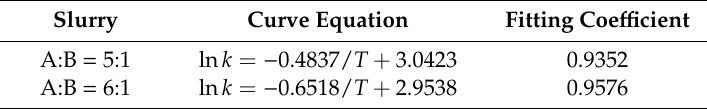
Table 3. The lnk-1 / T curve equation and fitting coe ffi cient. Table 3. The lnk-1/T curve equation and fitting coefficient.